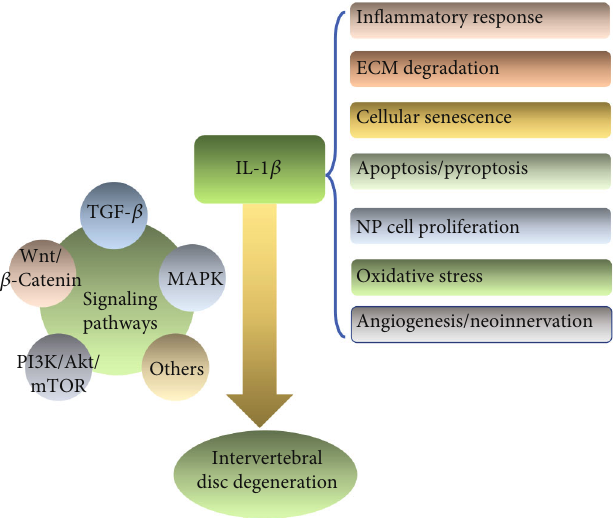
Figure 4: IL-1 β is involved in multiple pathological processes of intervertebral disc